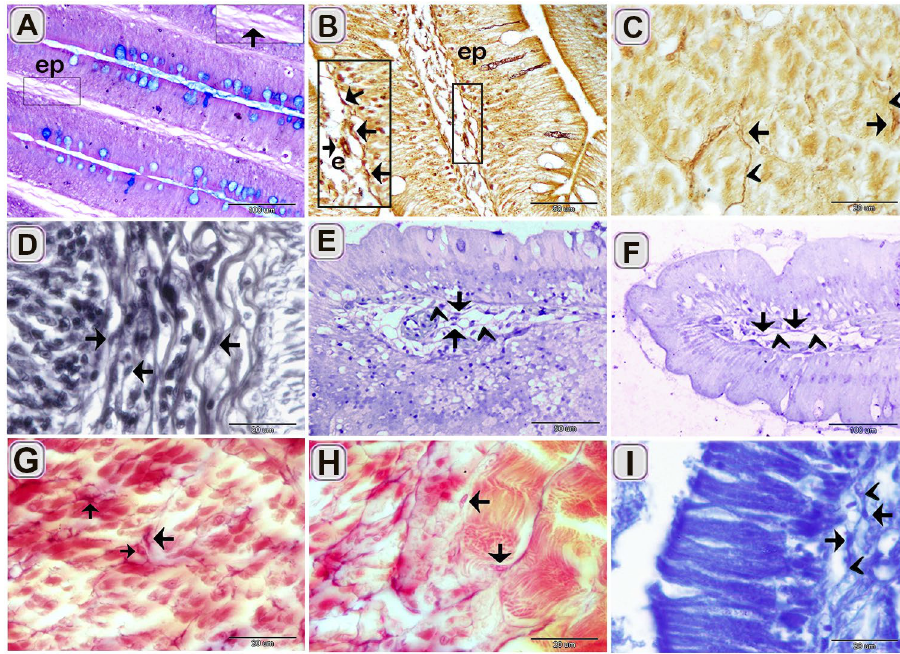
Figure 4. Recognition of TCs using Grimelius’s silver nitrate, Verhoeff stain, Giemsa, Weigert Van Gieson, bromophenol blue. Paraffin sections of the intestinal blub stained by Long ziehl neelsen ( A ), Grimelius’s silver nitrate ( B , C ), Verhoeff stain ( D ), Giemsa ( E , F ), Weigert van Gieson ( G , H ), bromophenol blue ( I ). ( A ) The cell body of subepithelial TC (arrow) stained bluish color that had affinity for Methylene blue. Note epithelium (ep). ( B ) The cell body of the subepithelial Telocytes (arrows) in closed vicinity to endocrine cell (e,arrow). Note epithelium (ep). ( C ) The cell body of TCs (arrows) located between muscles cells. Telopodes (arrowheads). ( D ) TC (arrow) stained black by Verhoeff stain. ( E , F ) TC (arrow) stained blue by Giemsa. Telopodes (arrowheads). ( G , H ) TC (arrow) stained positive for Van Gieson. Telopodes (arrowheads). ( I ) TC stained positive for bromophenol blue. Telopodes